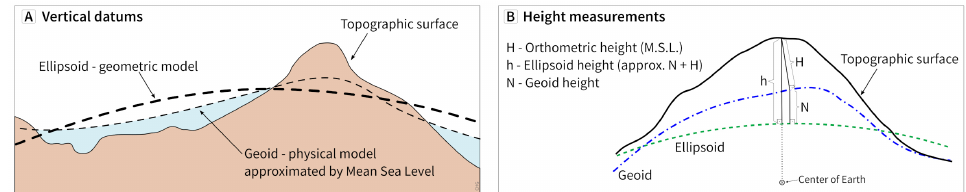
Figure 2. Vertical datums used as the starting point for elevation, and the resulting height